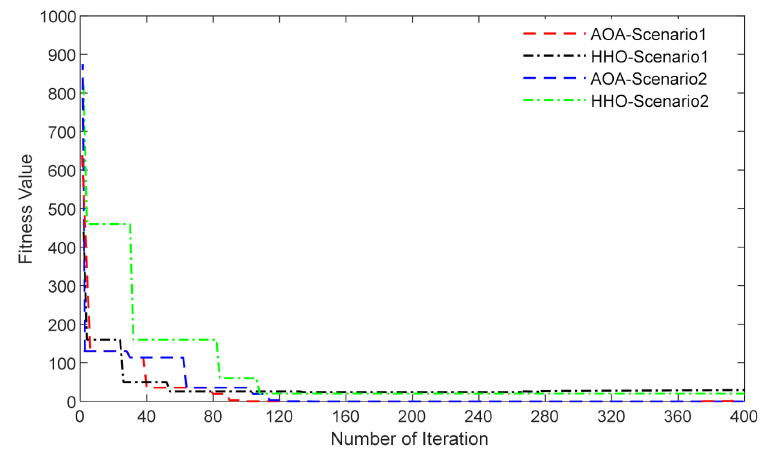
Figure 7. The convergence rate in finding the best